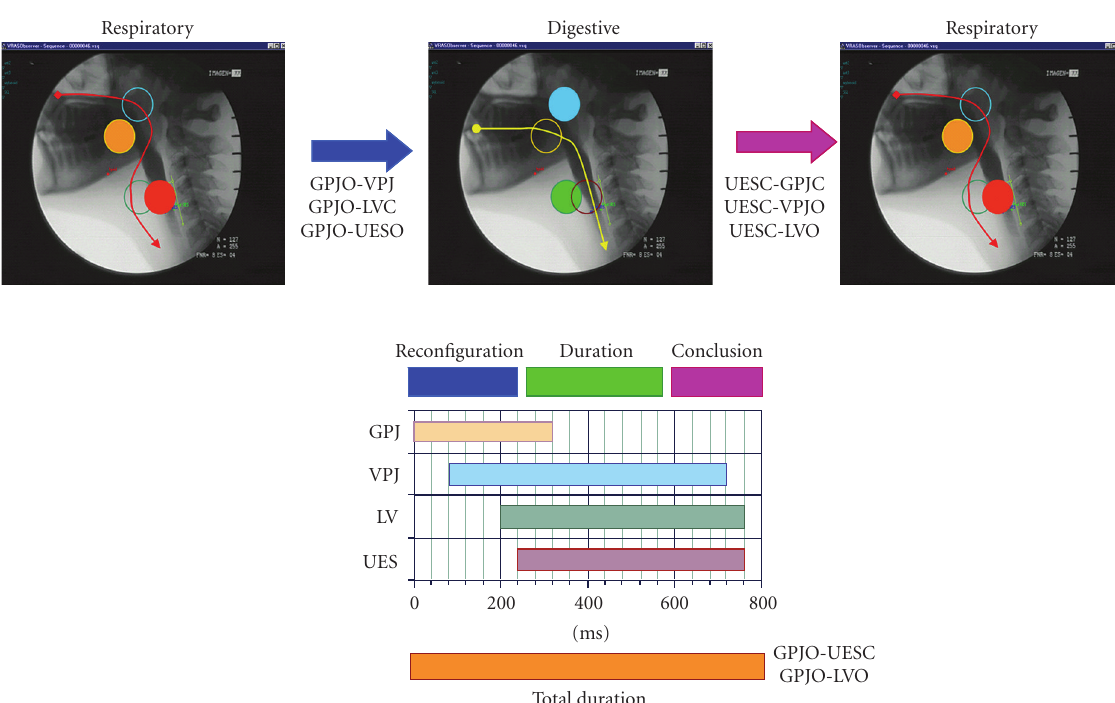
Figure 1: Configuration of the oropharynx during swallow response. Each phase of the response (reconfiguration, duration and conclusion) is defined by opening (O) or closing (C) events occurring at the glossopalatal junction (GPJ), velopharyngeal junction (VPJ), laryngeal vestibule (LV), and upper esophageal sphincter (UES).